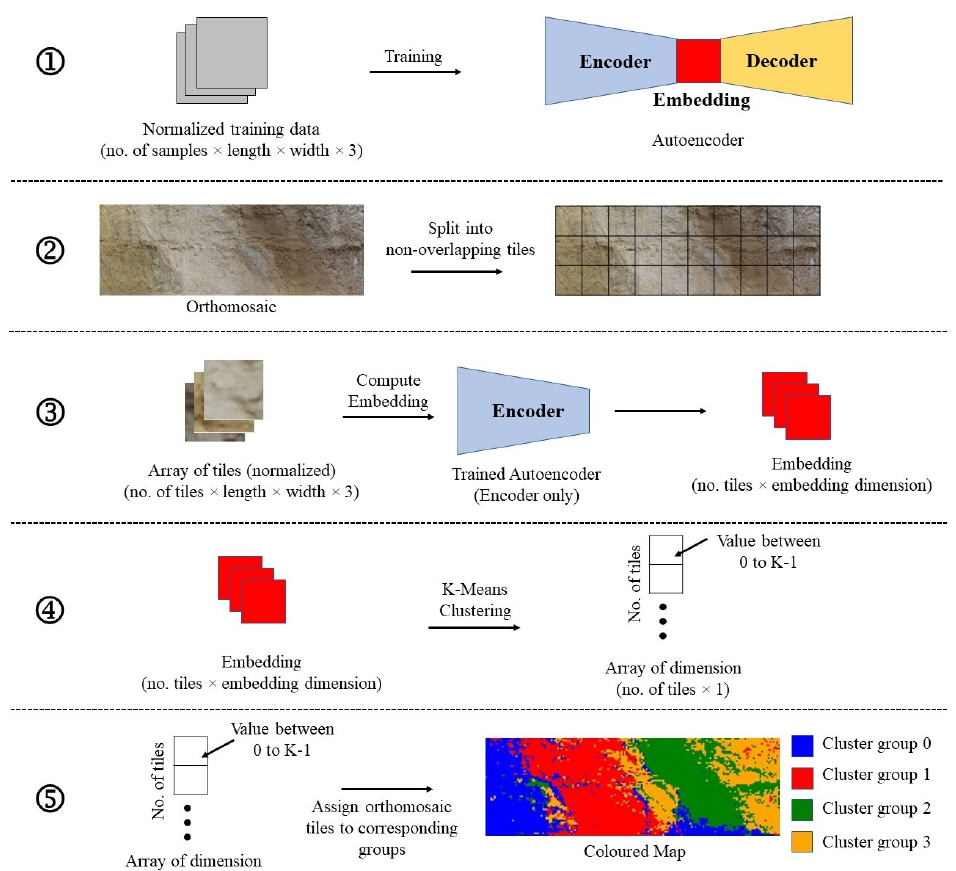
Figure 7. An illustration of the cluster map generation process using Autoencoder-first K-Means clustering. Table 4. Architecture of Model MT